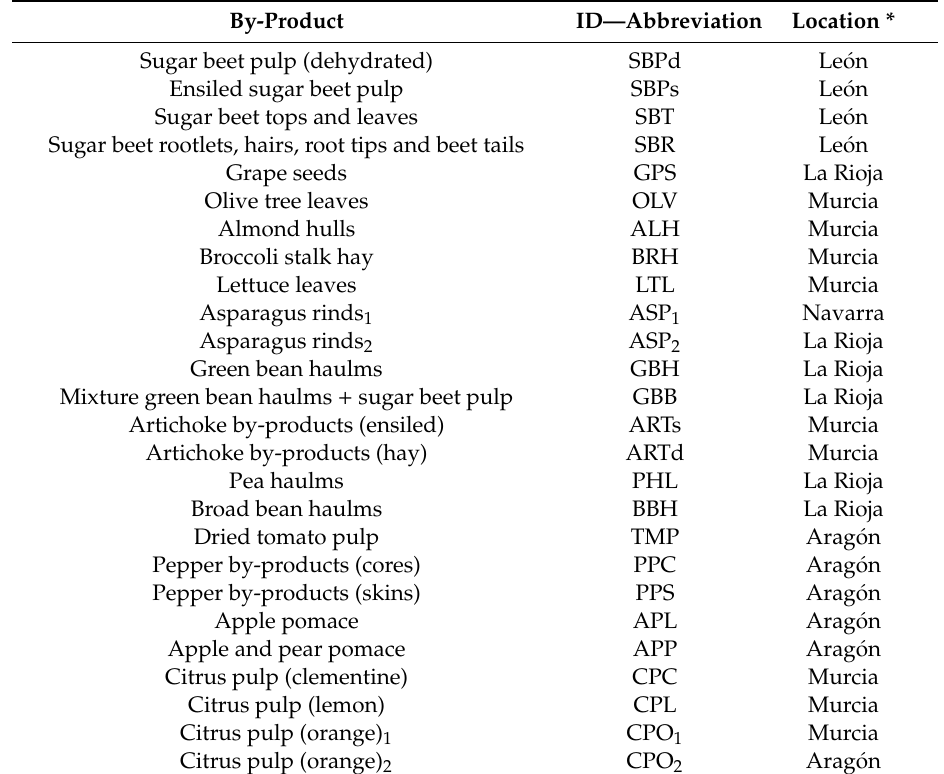
Table 1. By-products and their geographical